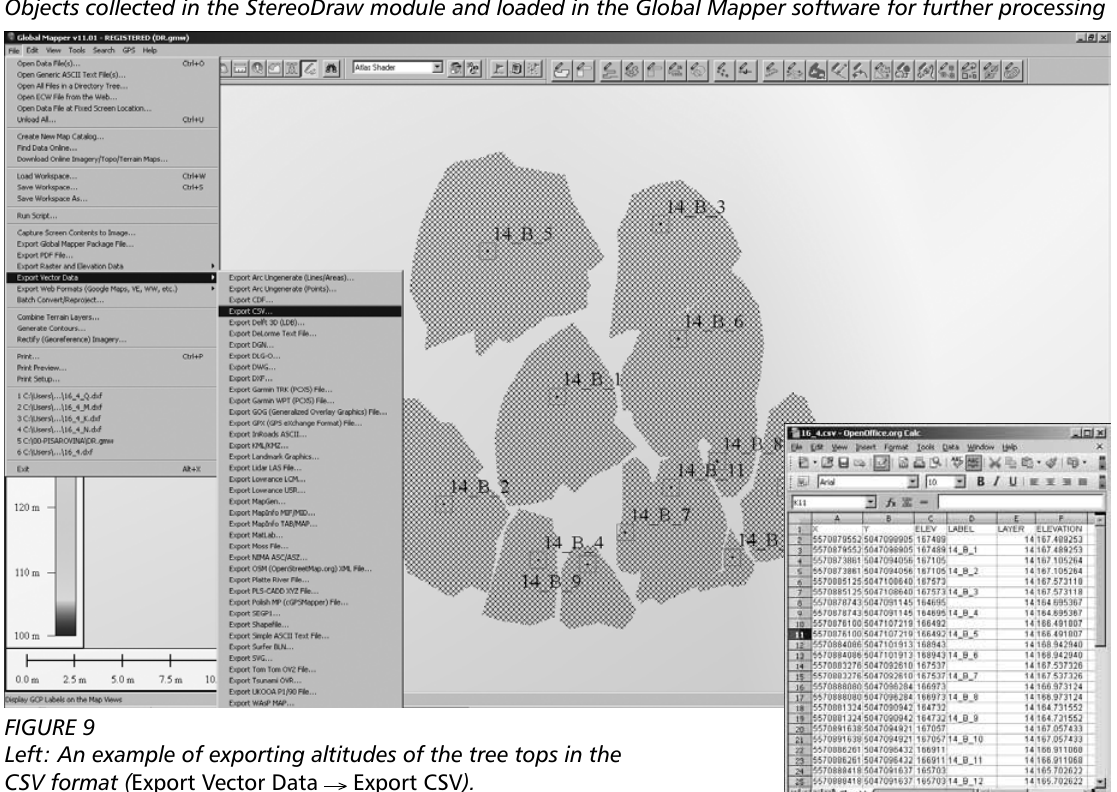
FIGURE 9 Left: An example of exporting altitudes of the tree tops in the CSV format ( Export Vector Data Export CSV ). Right: The corresponding exported data collected in